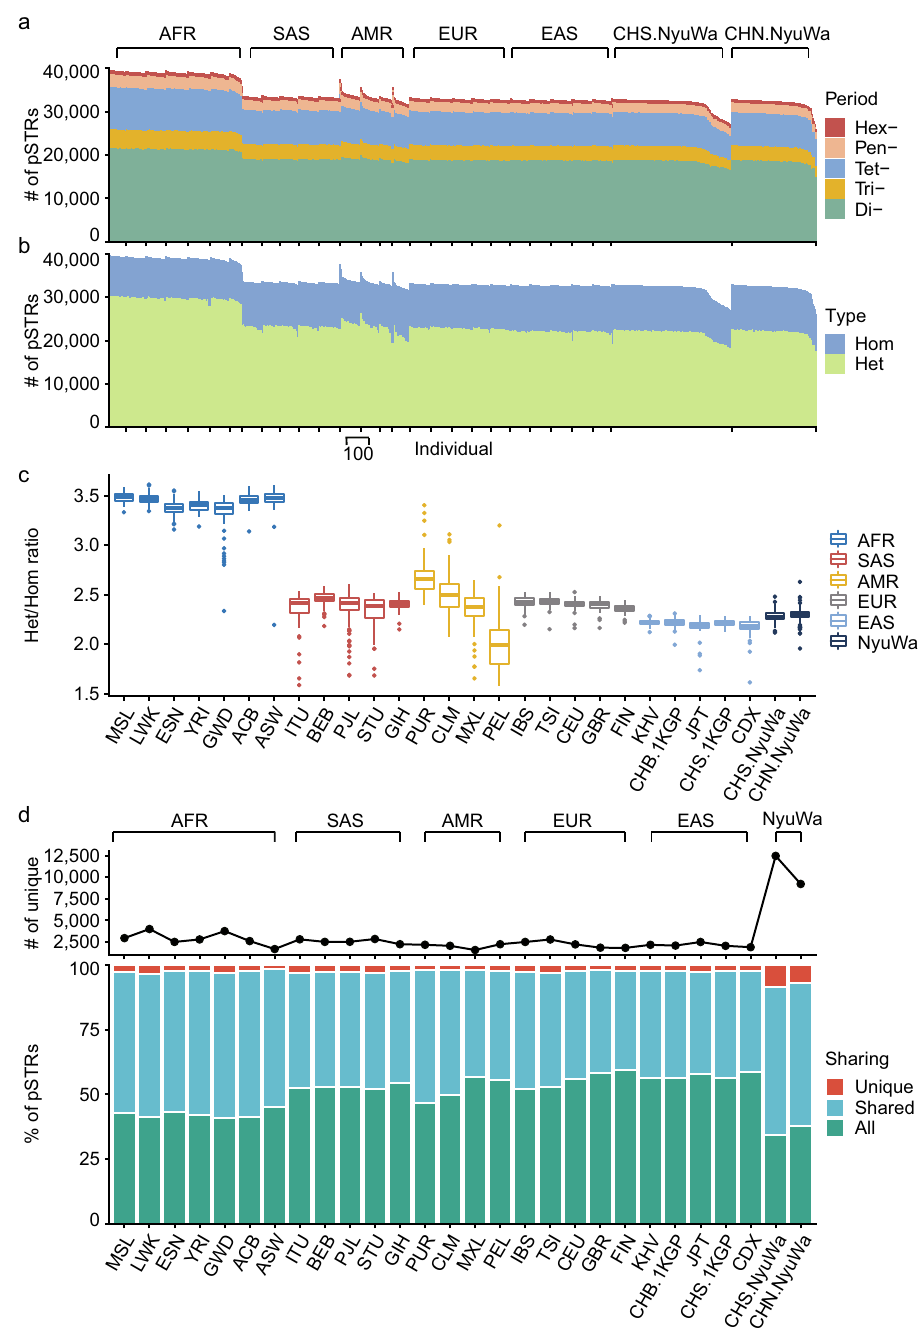
Fig. 5 | pSTR counts per sample and population sharing across different populations. a , b Number of pSTRs per individual strati fi ed by motif length ( a ) or state (heterozygous or homozygous) ( b ) of pSTR loci. c Distributions of the het- erozygote/homozygote ratio per individual ( n =3522) in populations of the 1KGP andNyuWadatasets.Horizontallinesindicatethemedianandboxesspanfromthe lower quartile (the 25th percentiles) to the upper quartile (the 75th percentiles). Whiskers extend to points that are within 1.5×IQR (interquartile range) from the upper or the lower quartiles. d Number of unique pSTRs (upper) and sharing of